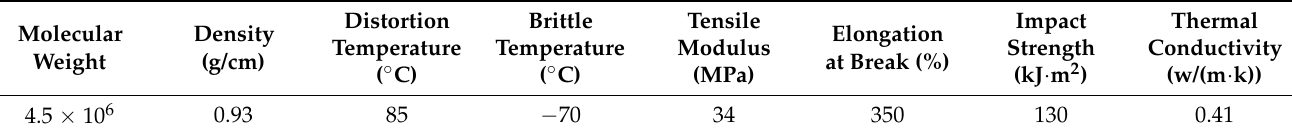
Table 1. Basic technical performances of ultra-high molecular weight polyethylene.